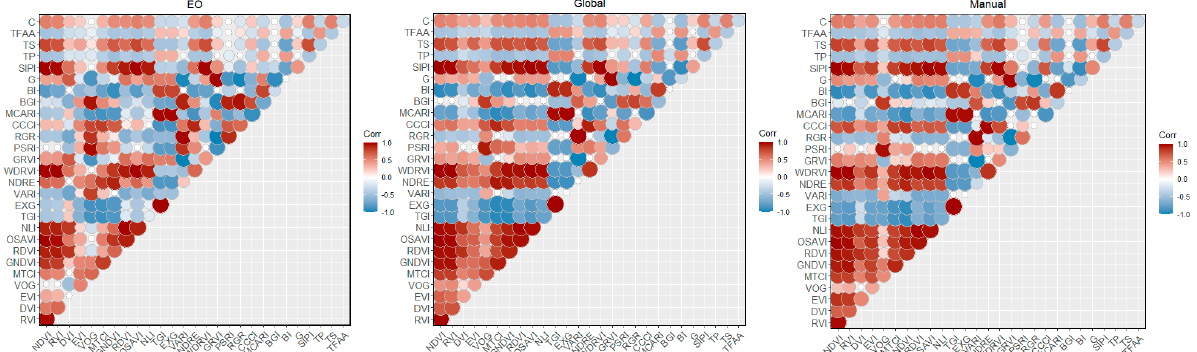
Figure 7. Correlation analysis results. TP, TS, TFAA, and C represent tea polyphenols, total sugar, total free amino acids, and caffeine, respectively. The blank sections indicate failed significance test.